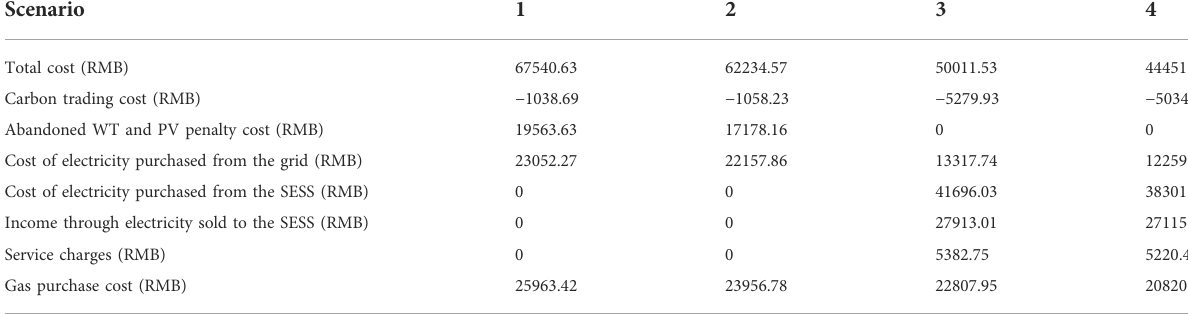
TABLE 3 Comparison of costs of each of the four scenarios of the MMGs on a typical day in spring.